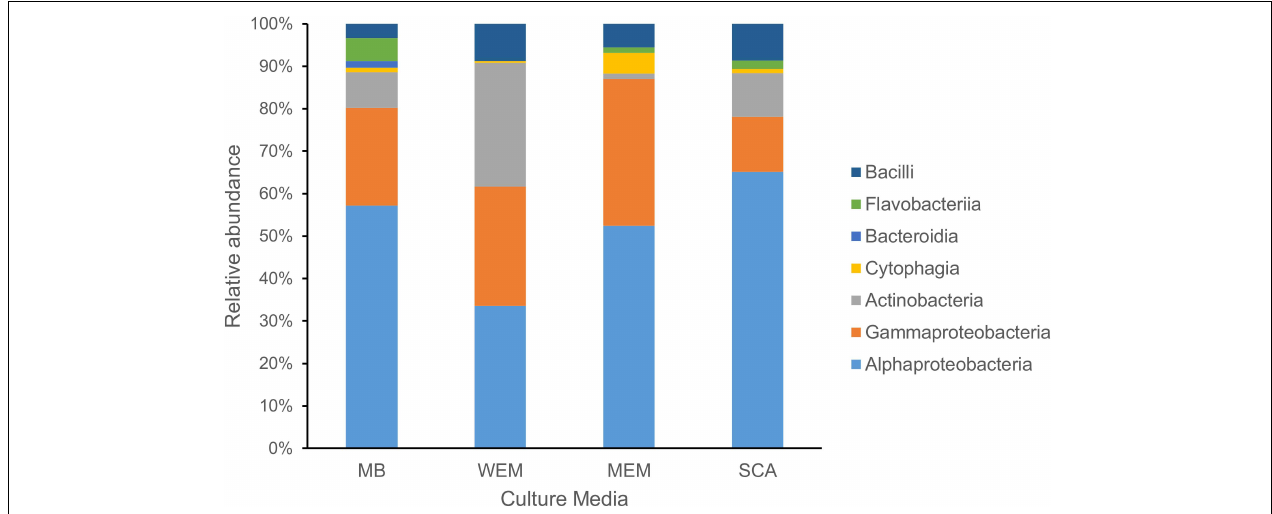
FIGURE 1 | Taxonomic diversity of cultivated bacteria obtained from the coastal sediments of three habitats using four culture media. The taxonomy of isolates was assigned based on the SILVA database. MB, marine broth 2216 (299 isolates); WEM, water extracted matter medium (274 isolates); MEM, methanol extracted matter (162 isolates); SCA, starch casein agar medium (301